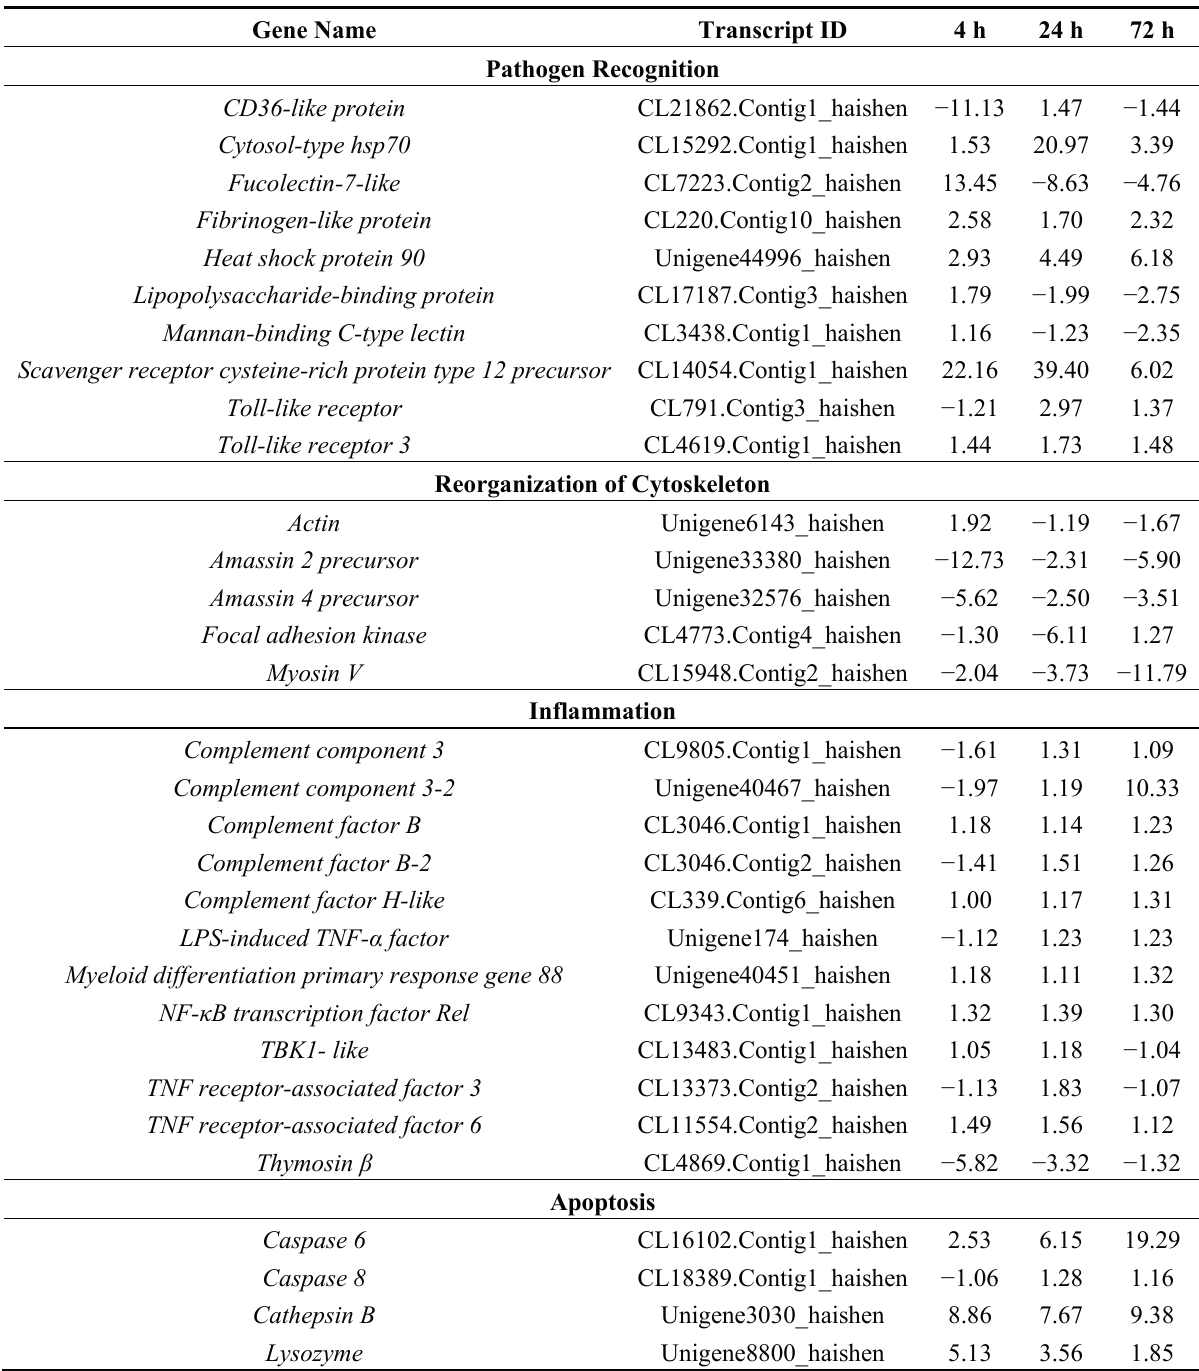
Table 1. A subset of candidate genes involved in the immune response to lipopolysaccharide (LPS) challenge. Values at three time points indicate the fold changes relative to the